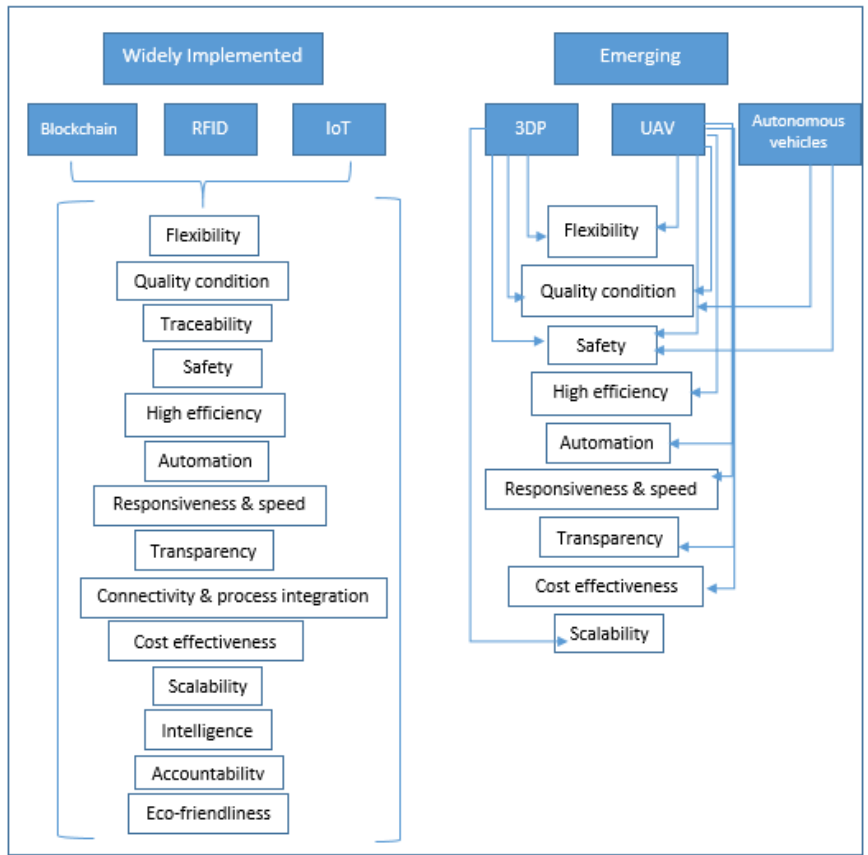
Figure 7. Interrelations between technologies and characteristics of perishable food supply chain.